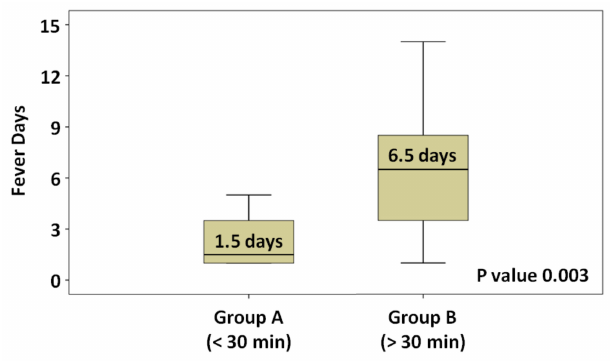
Figure 1. Median duration of fever days. Table 2. Effects of possible risk factors on fever days in patients receiving HSCT based on multiple regression